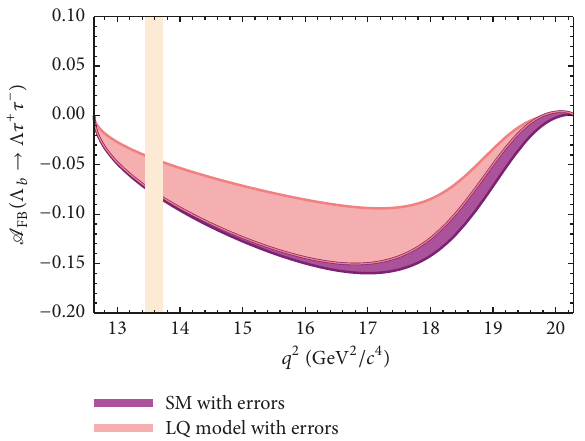
Figure 8: The dependence of A FB on 𝑞 2 for the Λ 𝑏 → Λ𝜏 + 𝜏 −